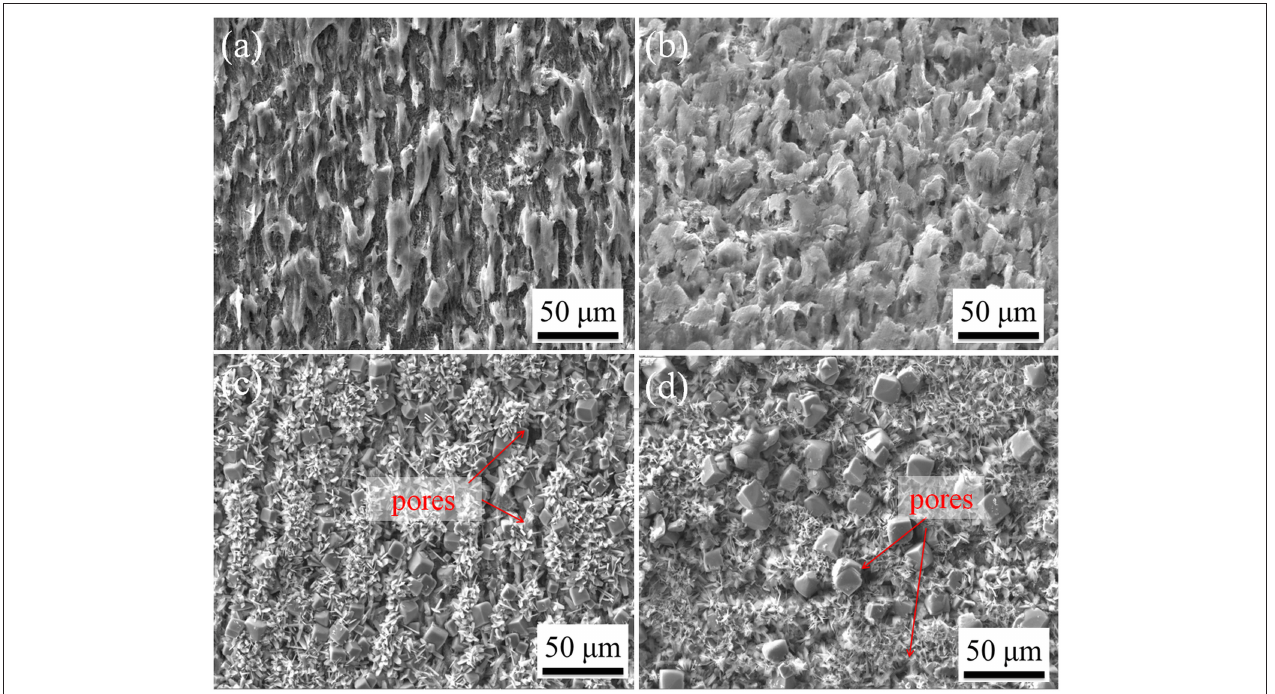
FIGURE 7 | SEM images of C1018 steel sample surfaces after 100h immersion in 1% NaCl solutions maintained at (a) 25 ◦ C, (b) 40 ◦ C, (c) 60 ◦ C, and (d) 80 ◦ C.